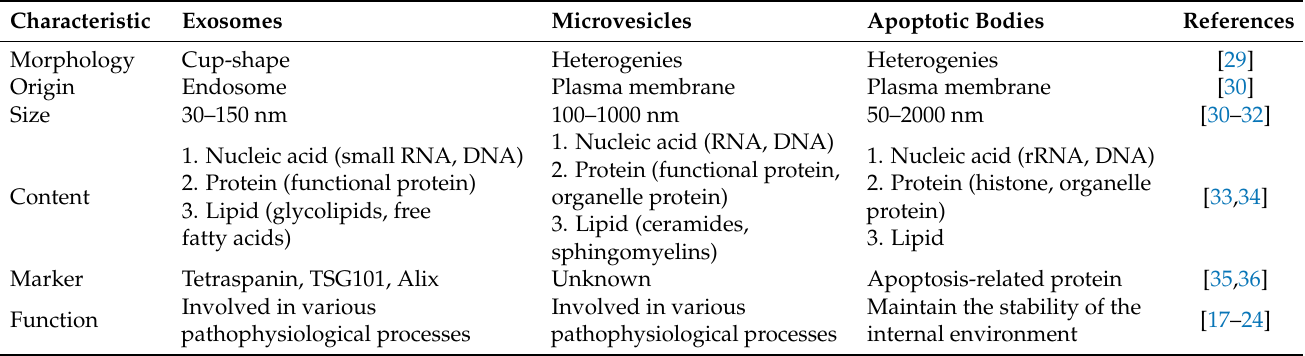
Table 1. Characteristics of different exosomes, microvesicles and apoptotic